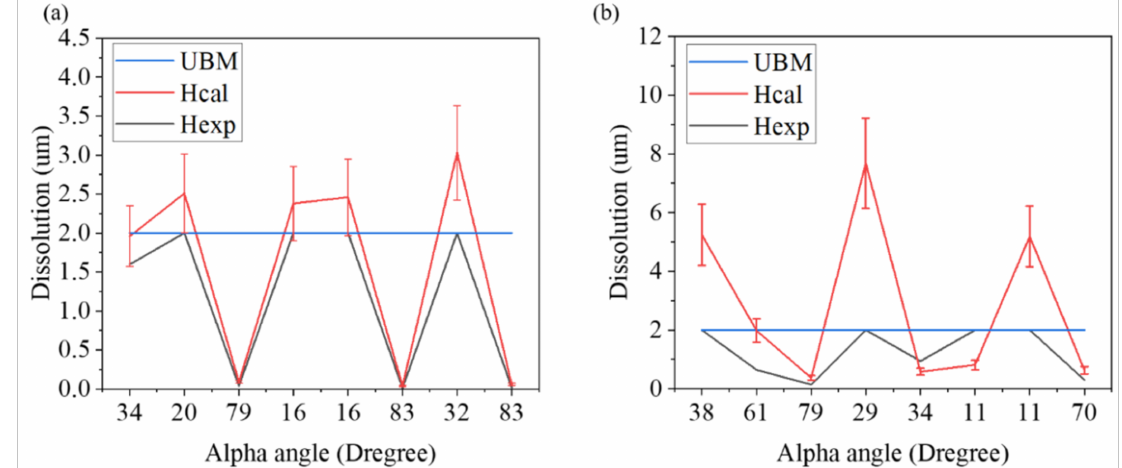
Figure 9. Theoretical versus actual consumption rates for ( a ) 8 × 10 4 A/cm 2 and ( b ) 1.6 × 10 4 A/cm 2 current density with different α -angles of Ni UBM. The thickness of the Ni UBM was only 2 µ m. For some of the low angle Sn grains, the theoretical dissolution thickness is over 2 µ m, which means that all the 2- µ m Ni UBM dissolved after the EM test. The experimental results also supported the theoretic